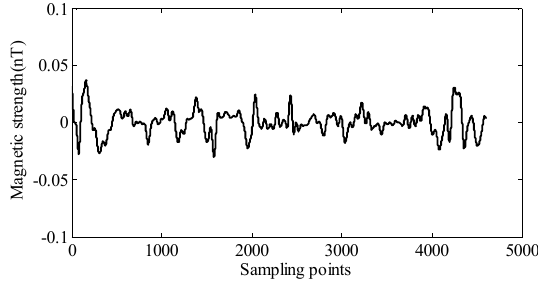
Figure 8. The background geomagnetic interference field.